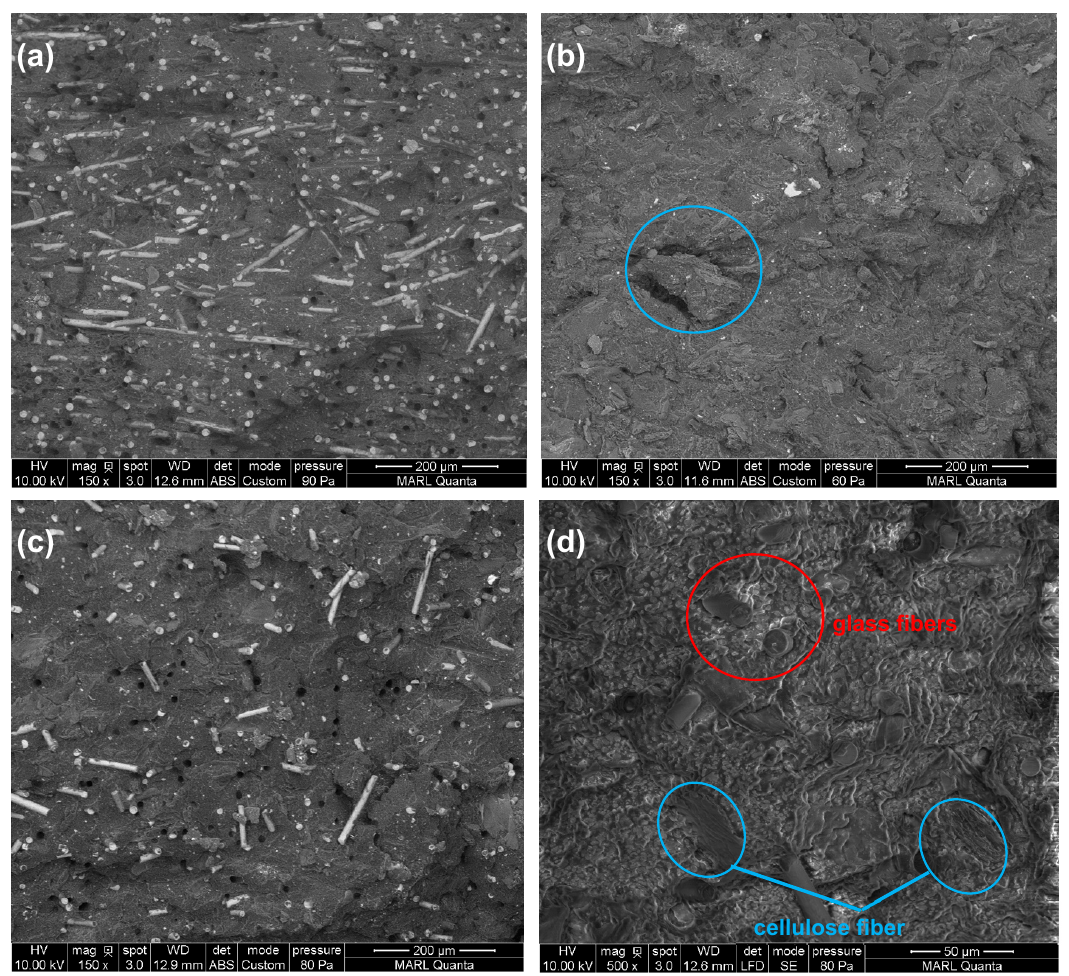
Figure 5. SEM images of the fracture surfaces of ( a ) blend + 30% glass fiber; ( b ) blend + 30% cellulose fiber (circled); and ( c and d ) blend + 15% glass fiber + 10% cellulose fiber at 150× and 500× respectively.